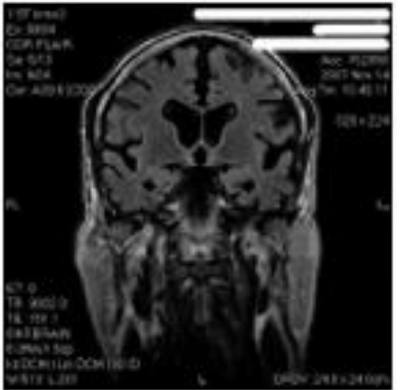
Figure 2. Brain MRI of a 74-year-old former ice hockey player. Coronal T1 showing significant fronto-temporal-parietal cortical and sub-cortical atrophy with ventricular dilatation, hippocampal atrophy bilaterally, and diffuse axonal